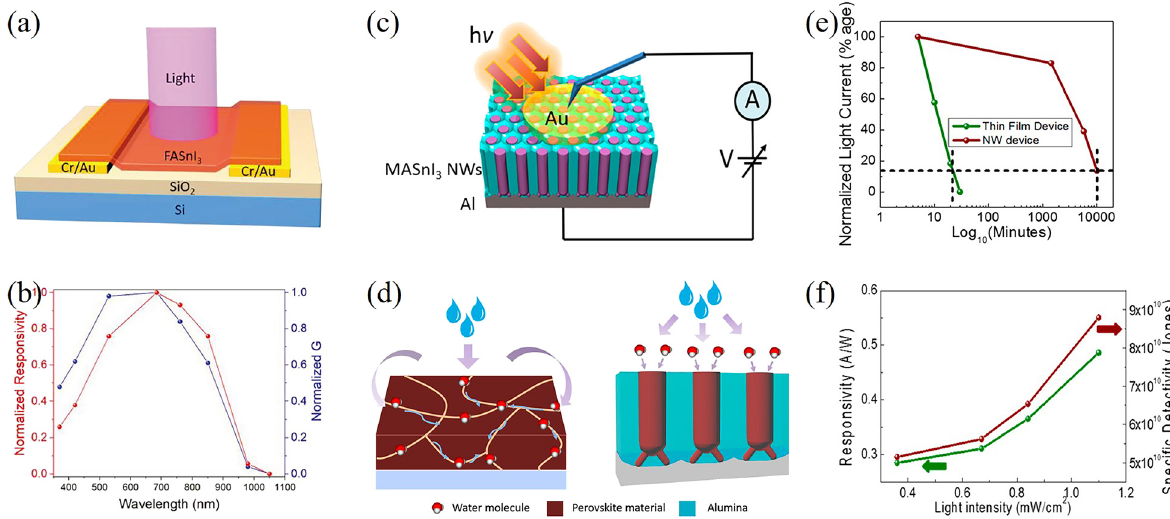
Figure 2: NIR photodetectors based on FASnI 3